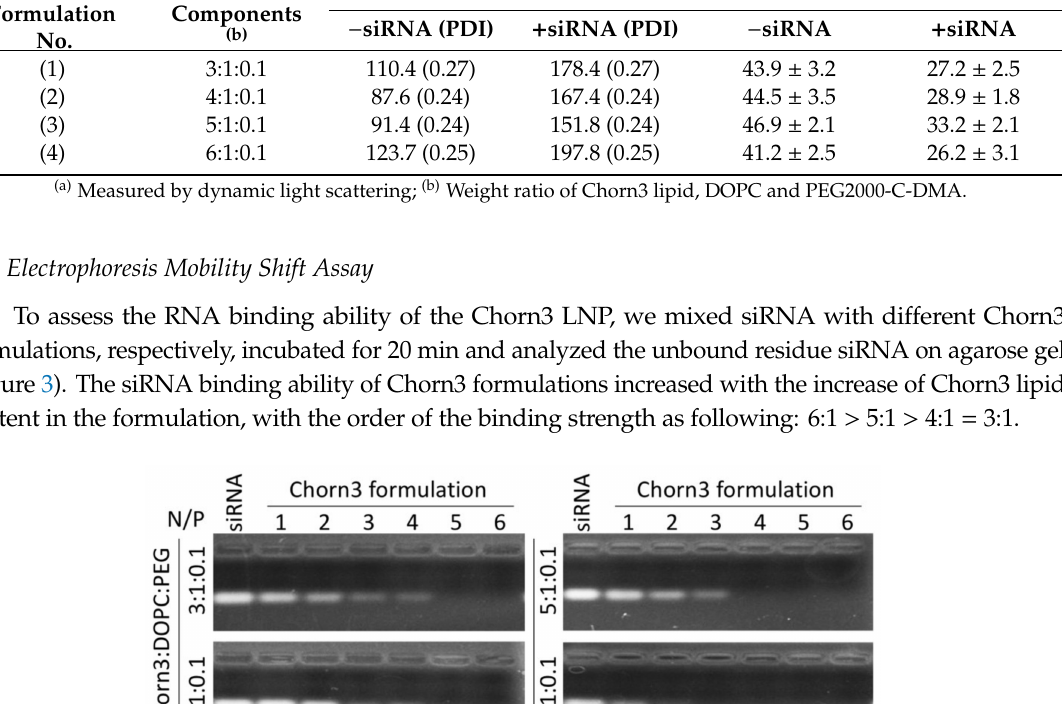
Table 2. Particle size (a) and zeta potential of Chorn3 lipid nanoparticles (LNP). Chorn3